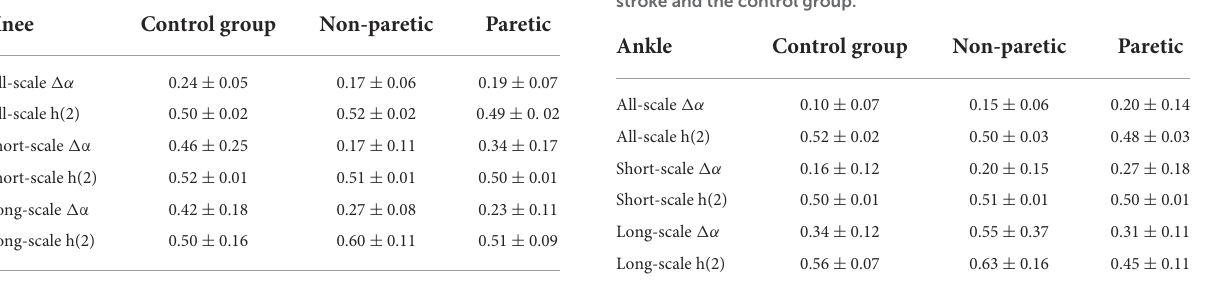
TABLE 1 Mean and standard deviation for the shuffled series on knee angle.